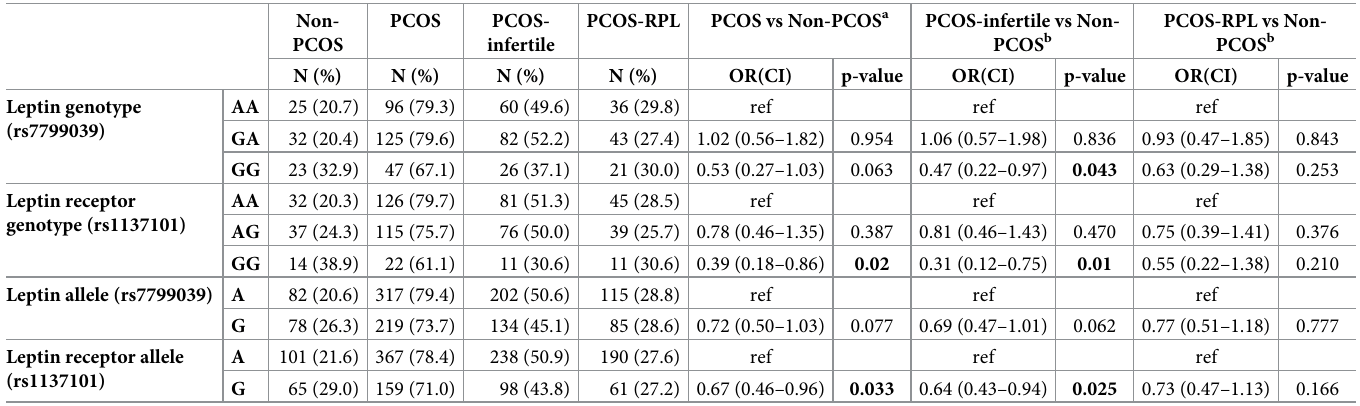
95% confidence intervals (CIs) of women with PCOS-infertile and PCOS-RPL, in reference to the non-PCOS group (Table 3). Binary logistic regression was also used to explore the effect of Table 2. Genotypic and allelic distribution of LEP (rs7799039) and LEPR (rs1137101) polymorphisms in PCOS and non-PCOS